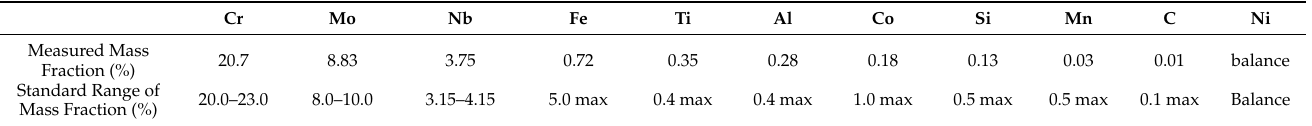
Table 1. Measured composition of the virgin IN625 feedstock powders used in this work as provided by the vendor-supplied data sheet and determined following ASTM E1019 standard as well as the allowable range of composition of IN625. The testing relative uncertainty for elements with mass fraction between 5 and 25% is ± 5% of the value, for elements with mass fractions between 0.05% and 4.99% is ± 10% of the value, for elements with mass fractions less than 0.049% is ± 25% of the